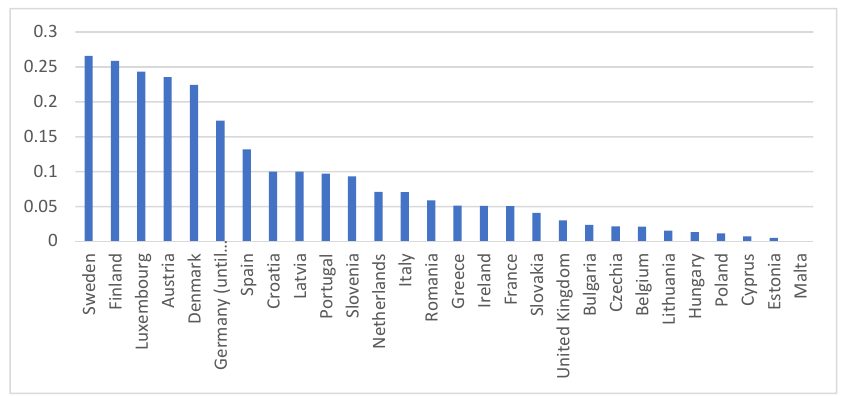
00.050.10.150.20.250.3 Figure 1. Development taxonomic ratio values (TMR) for the examined countries in 2004. Source: author’s own elaboration. Figure 2. Development taxonomic ratio values (RMT) for the examined countries in 2009. Source: author’s own elaboration. Figure 3. Development taxonomic ratio values (RMT) for the examined countries in 2014. Source: author’s own elaboration. Figure 4. Development taxonomic ratio values (RMT) for the examined countries in 2019. Source: author’s own elaboration. Table 1 presents the ranking of the surveyed countries by level of RES use for elec- tricity production for four selected years (in five-year intervals). Table 1 and Figures 1–4 intentionally present the same data in two graphical forms, as they have varying usability for the reader.